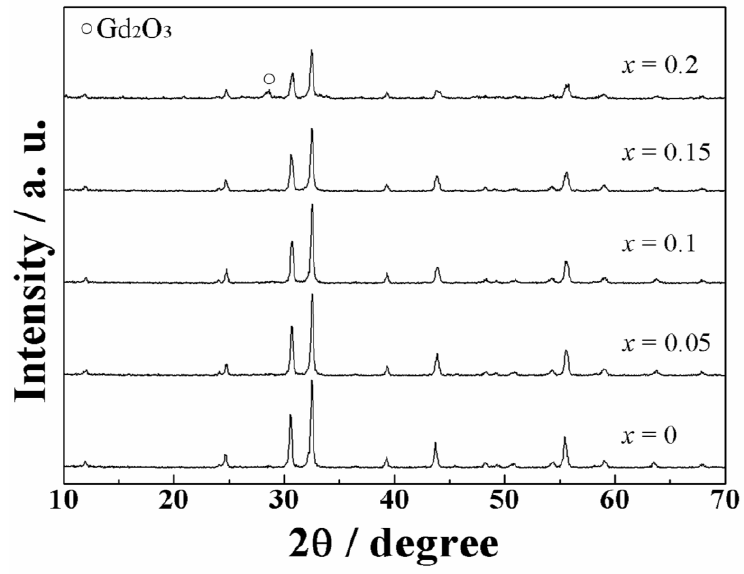
Gd )OBr:5%Tb 3+ (0 ≤ x ≤ 0.2) phosphors. 1- x x